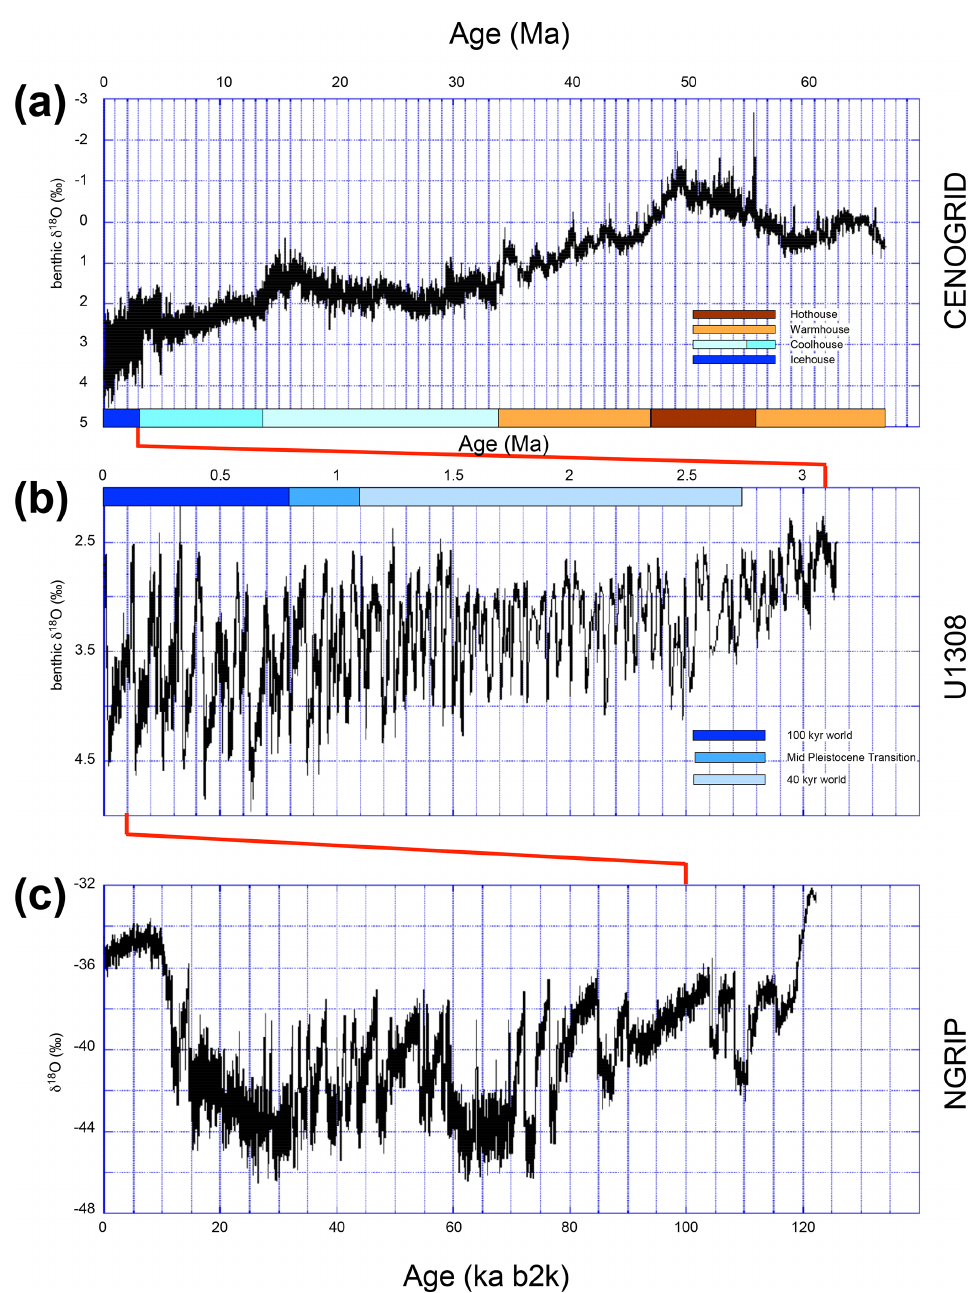
Figure 1. Earth climate history represented by two marine records and an ice core one. (a) Record of benthic δ 18 O of the CENOGRID stack for the last 66Myr; the hothouse, warmhouse, coolhouse, and icehouse intervals, following Westerhold et al. (2020), are indicated along the abscissa. (b) Benthic δ 18 O record of the U1308 marine core (Hodell and Channell, 2016a) for the last 3.2Myr; the 40kyr, 100kyr, and mid-Pleistocene transition (MPT) intervals are indicated along the top of the diagram. (c) Record of 122kab2k δ 18 O of the NGRIP ice core (Rasmussen et al., 2014) for the last 122kyrb2k. Here “b2k” means before